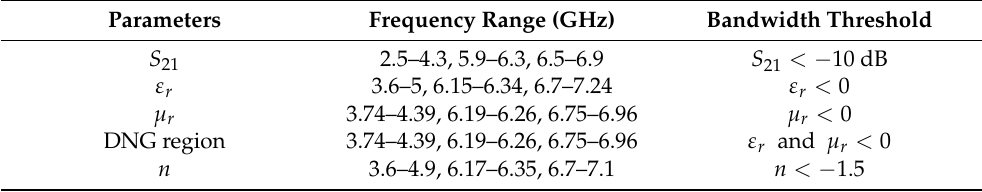
Figure 4. ( a ) Refractive index quantities and ( b ) effective impedance against the frequency of the proposed MM structure. Table 2. Effective parameter characteristics of the proposed DNG MM